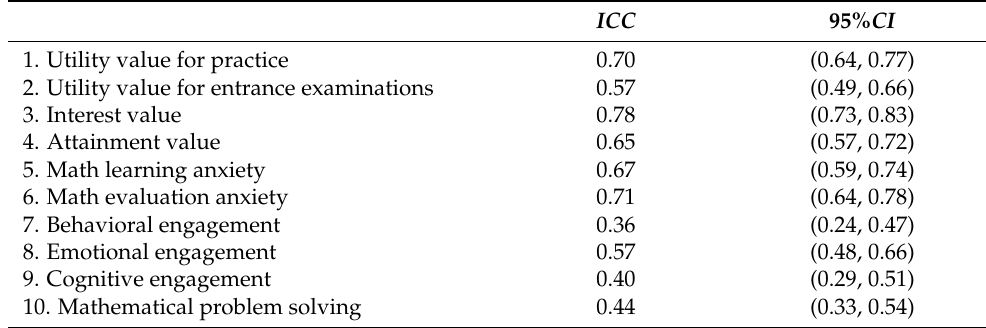
Table 4. ICC s for task value, math anxiety, engagement and mathematical problem solving.